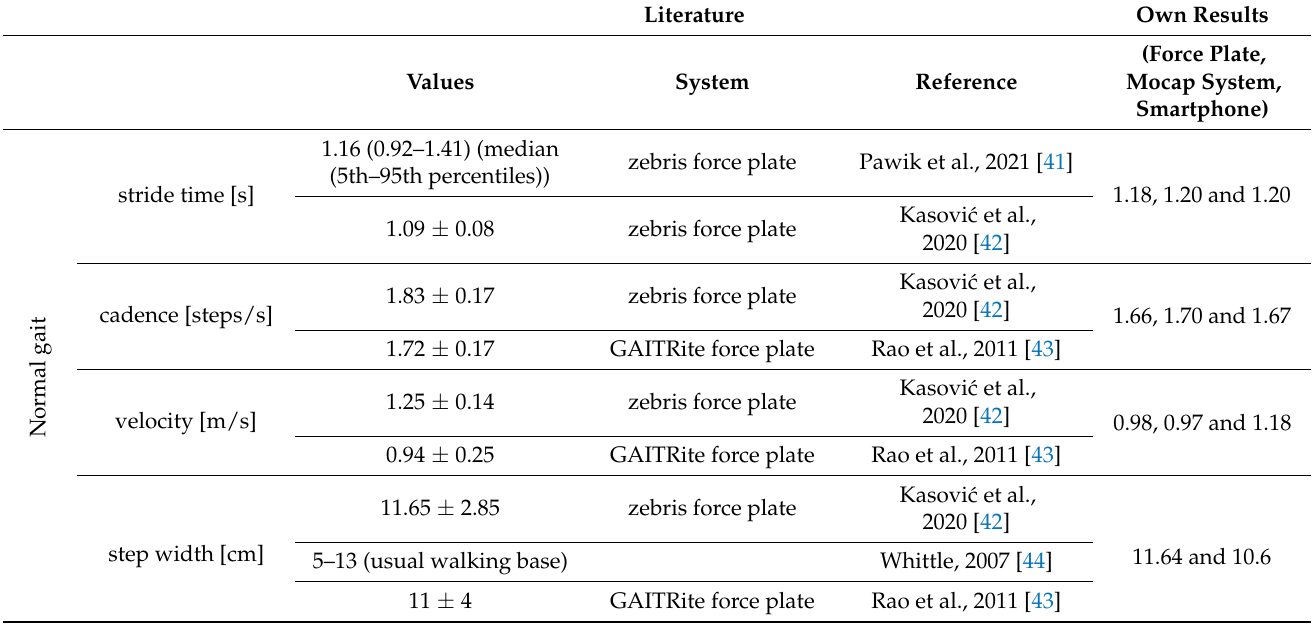
Table 9. Overview of values of gait variables found in the literature versus results of this study. A value description is given, unless values are mean ±